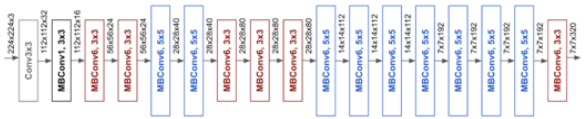
Figure 3. Network architecture of EfficientNet-B0 (Tan and